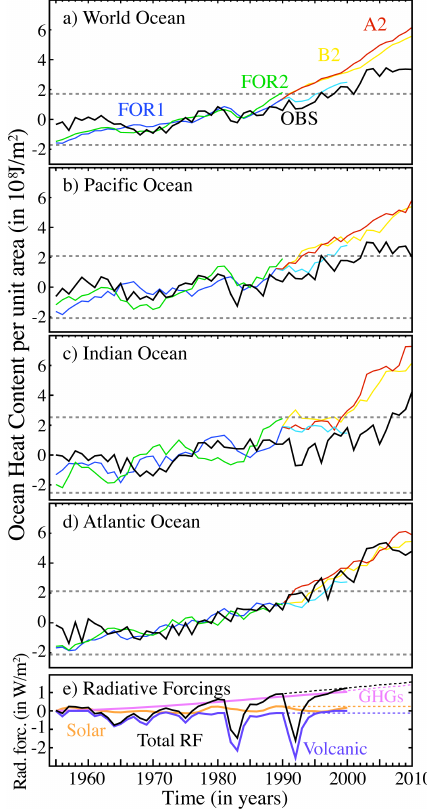
Fig. 2. (a–d) Evolution of OHC700 anomalies normalised per unit area (in 10 8 Jm − 2 ) in the upper 700m of the world ocean and the three main ocean basins. Observed OHC700 (OBS) is calcu- lated from temperature profiles of the Ocean Climate Laboratory at NODC. Simulated OHC700 anomalies are computed for the forced simulations FOR1 and FOR2 from 1955 to 1990, and for the sce- nario runs A2 and B2 from 1991 to 2010. A continuation to year 2000AD in FOR1 is highlighted as a light blue line. Horizontal dashed lines represent a threshold of ± 2 standard deviations from the long-term variability in CTRL. The reference period for the anomalies is 1960–1990. (e) Estimates of the radiative forcings ex- pressed as changes with respect to year 1955. Dotted lines corre- spond to projections of the radiative forcing in the A2 scenario